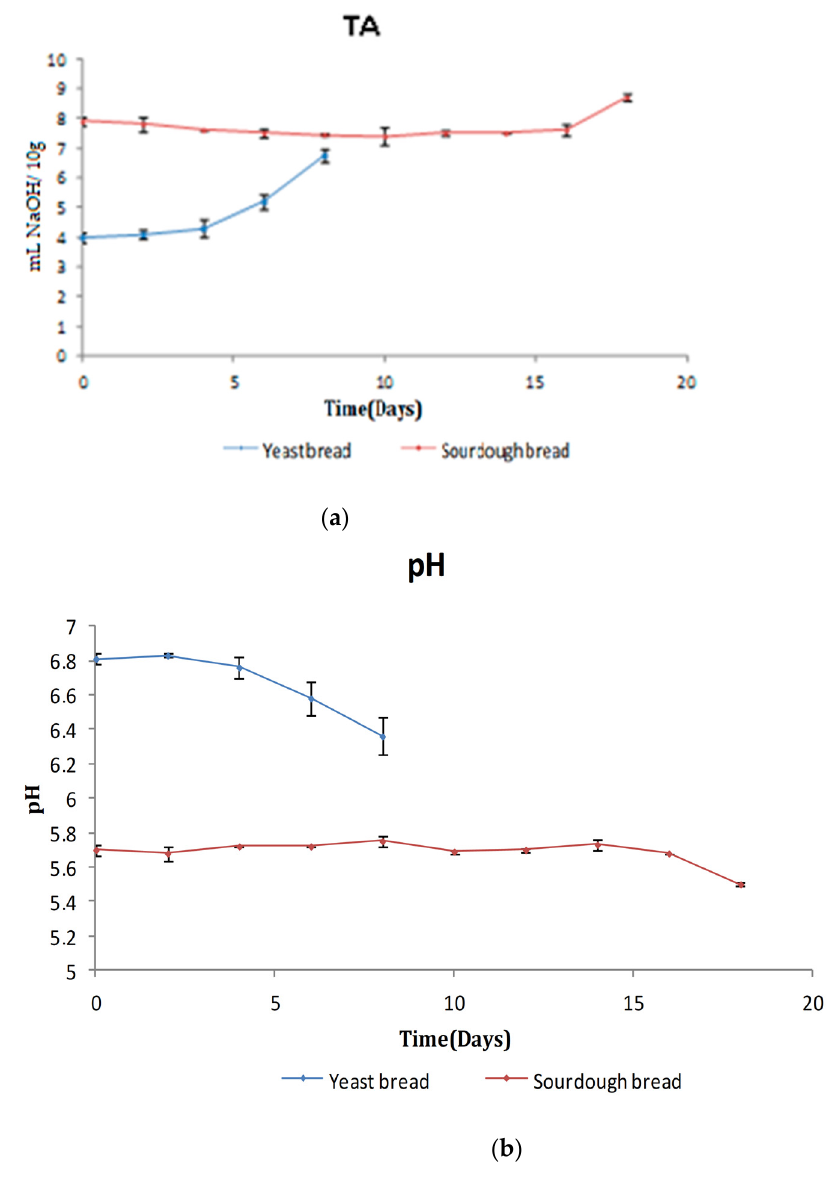
Figure 4. Changes in ( a ) titratable acidity and ( b ) pH in yeast leavened and sourdough bread as a function of time.